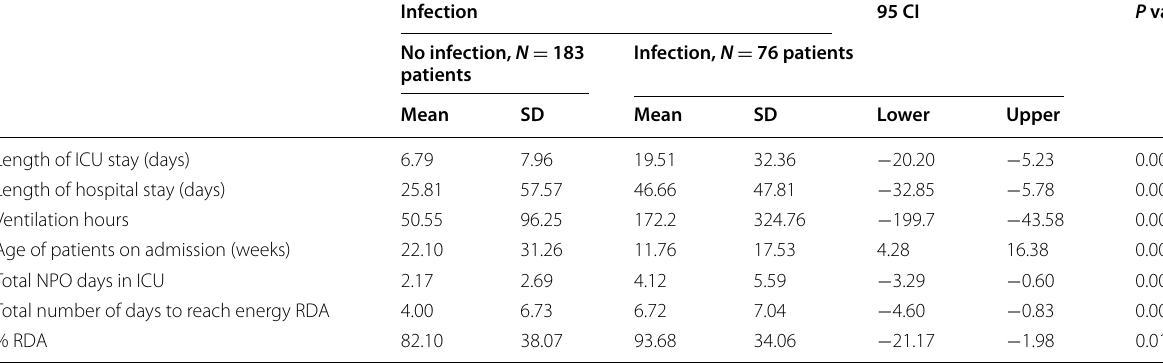
Table 2 Relationship between infection and continuous risk factors